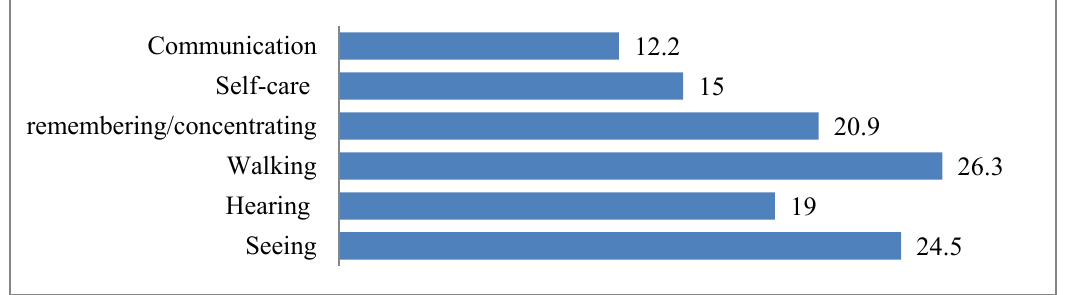
Figure 5. The proportion of older persons with difficulties in different functions in 2019 (in %).